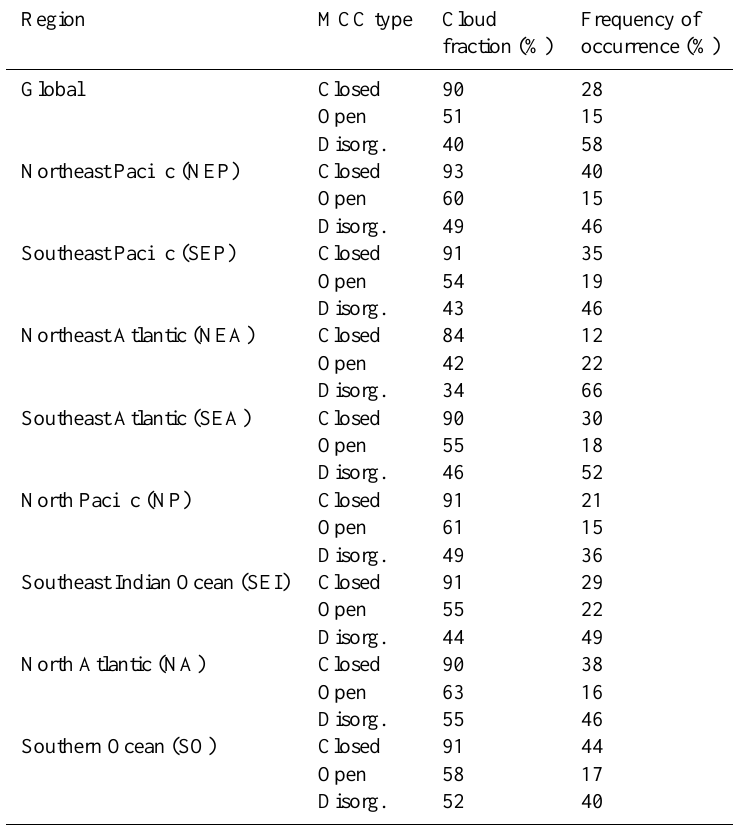
Table 4. Annually averaged cloud fraction and frequency of occurrence of MCC for each region defined in Table 1. The statistics are based on 1 year of data from